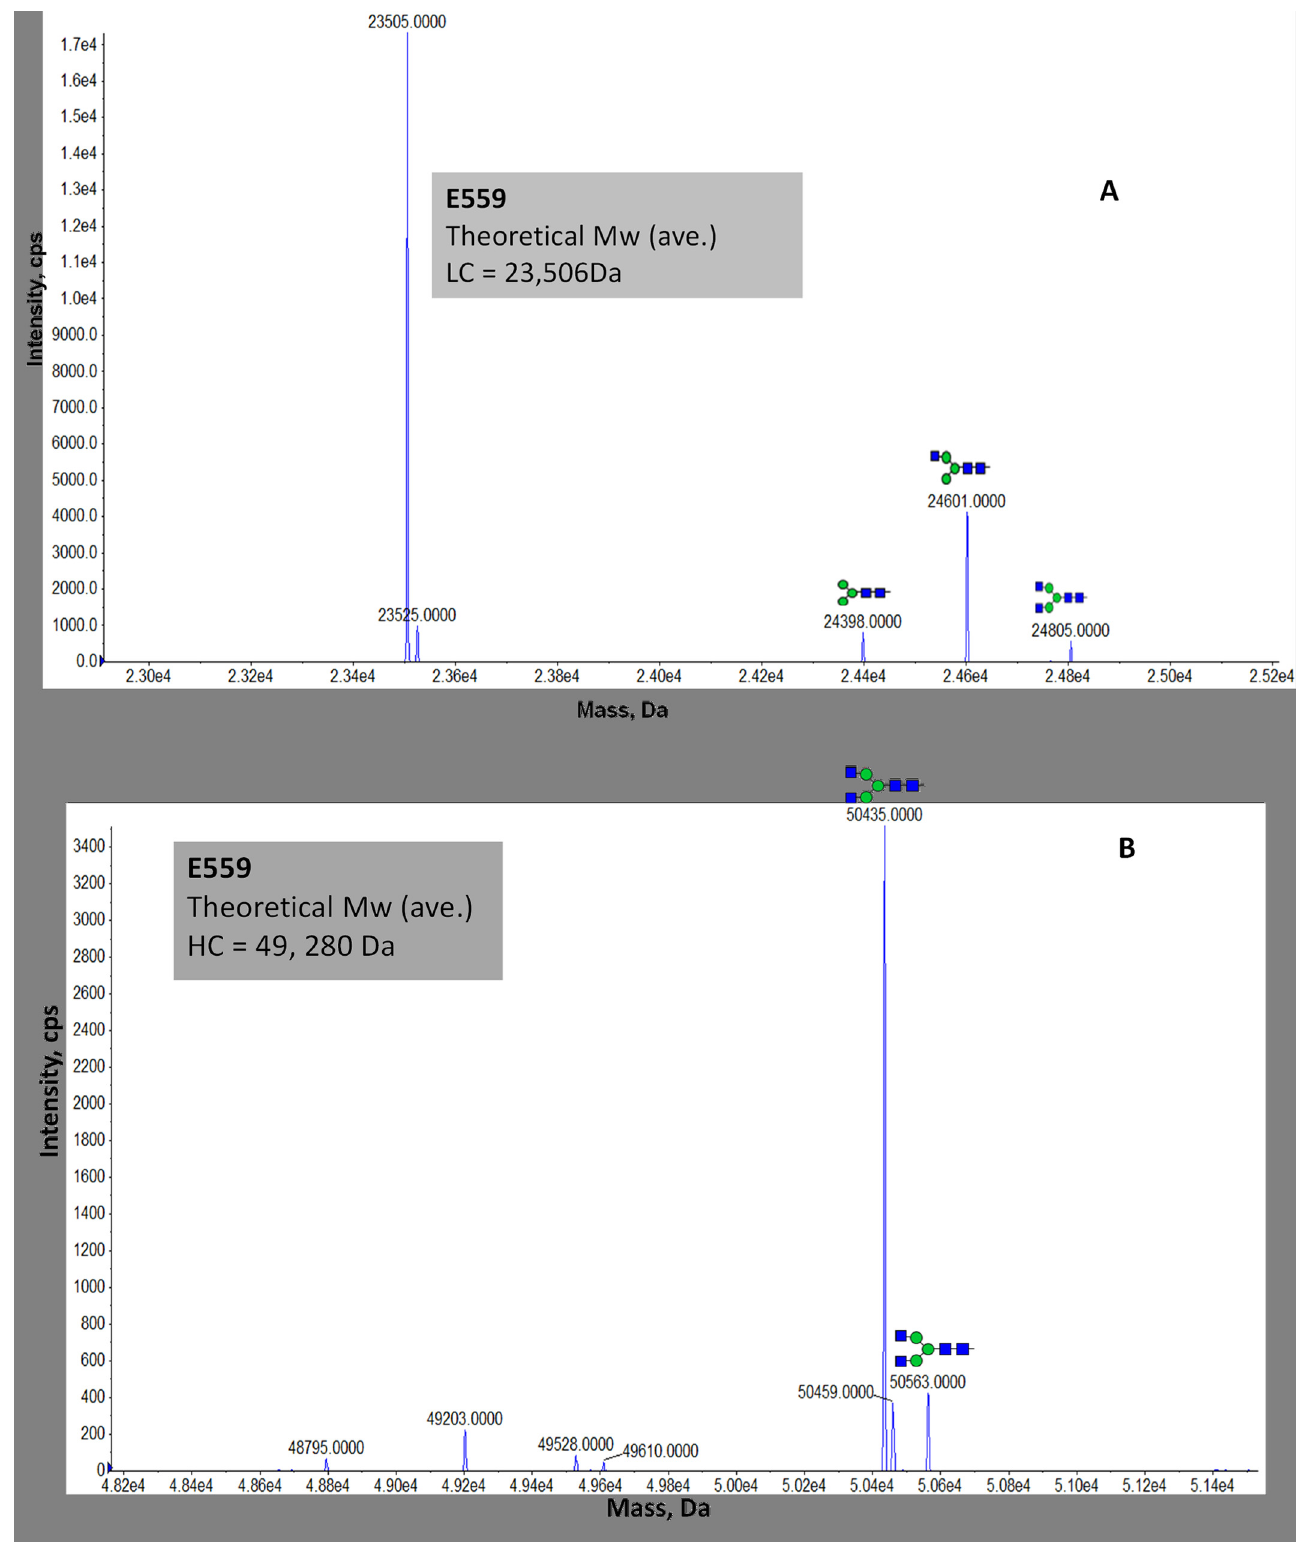
Fig 2. Deconvoluted spectrum of intact, reduced E559 LC (A) and intact, reduced E559 HC (B) .Theoretical molecular weights for LC and HC indicated. Detected N-linked glycoforms are shown. The N-glycan nomenclature used was from www.proglycan.com. doi:10.1371/journal.pone.0159313.g002 PLOS ONE | DOI:10.1371/journal.pone.0159313 July 18,